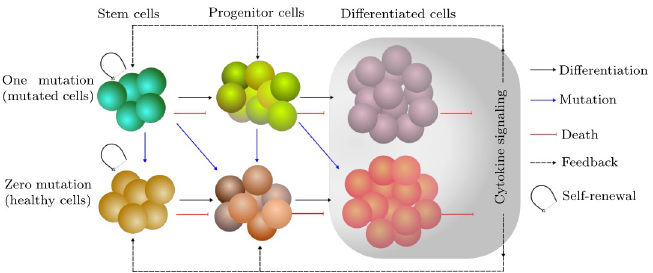
Fig 1. Schematics of the model. Co-evolution of normal and mutated cells in the presence of feedback regulation. The model captures the evolution of stem cell lineages with zero and one mutation. Stem cells can self-renew, differentiate and undergo apoptosis. The resulting progeny continues to proliferate until terminally differentiates into mature cells. Note that, during the division of a cell, there is a probability of getting a mutation. The feedback originates from the mature cells and thus regulates the self-renewal and proliferation rate of stem and progenitor cells,